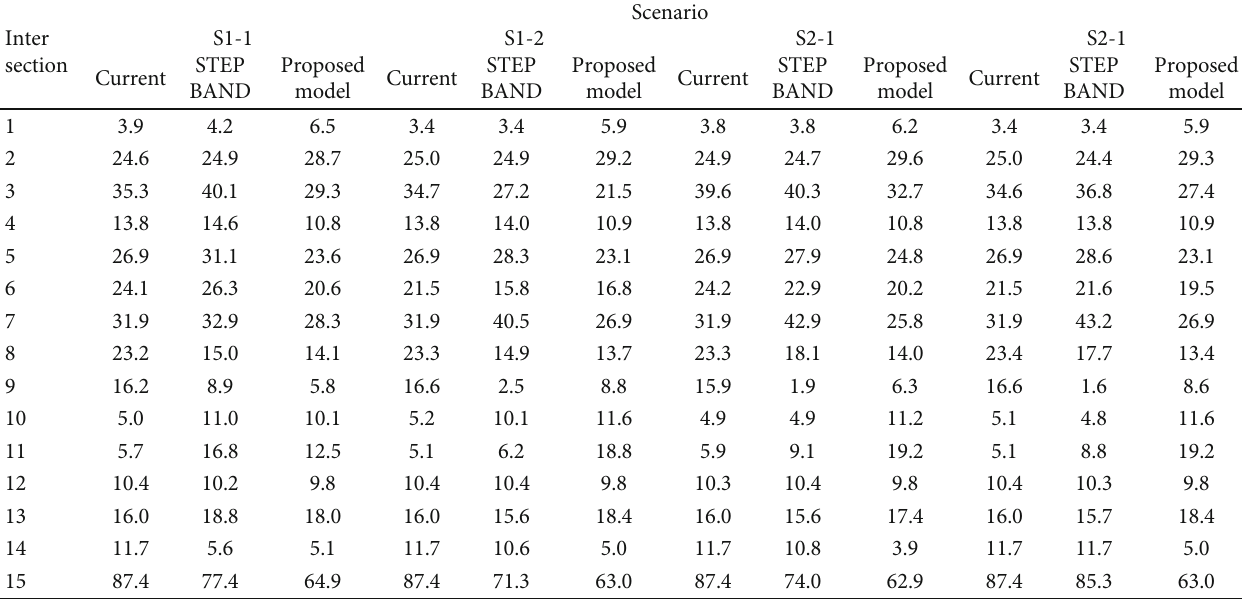
Table 4: Intersection delays